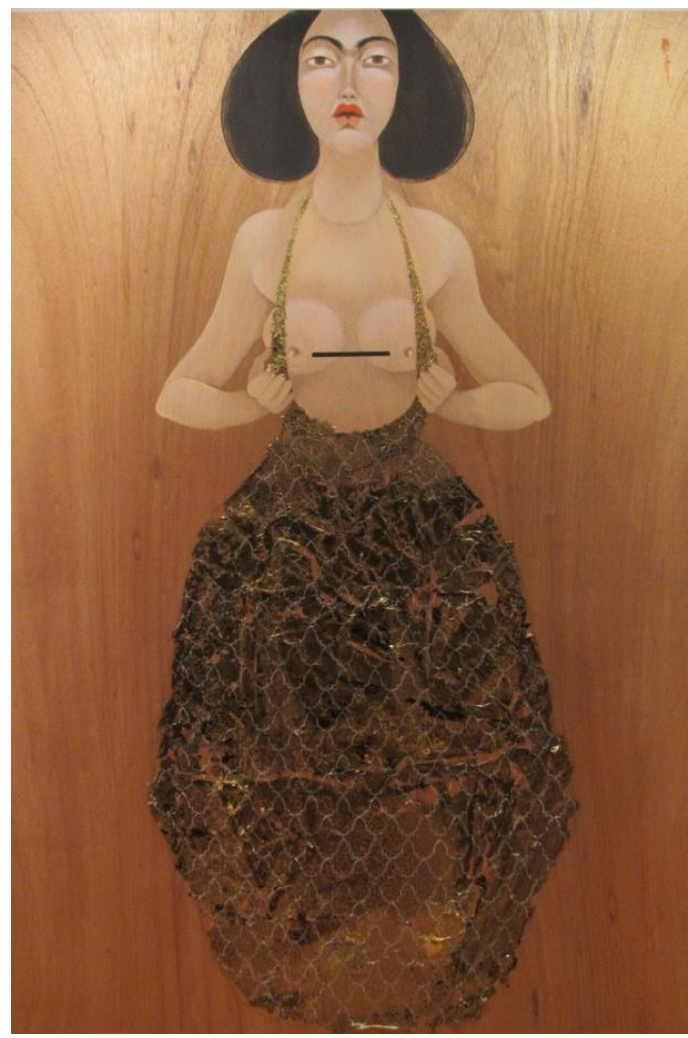
Figure 11 Hayv Kahraman, Boob Gold (2018). Oil on wood (Photo: